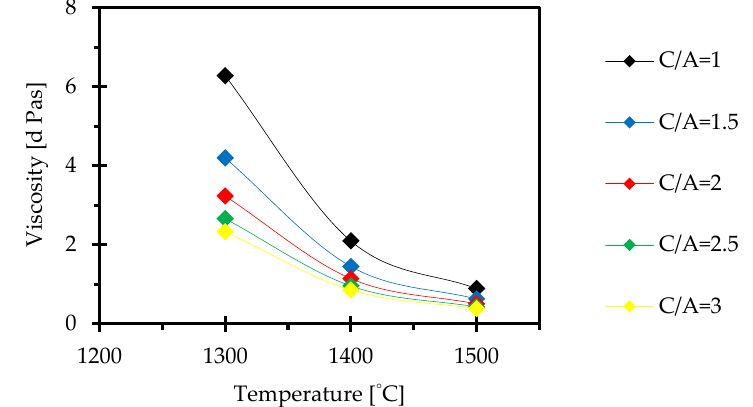
Figure 16. Viscosity of C-series mould powders estimated by FactSage software as a function of temperature.